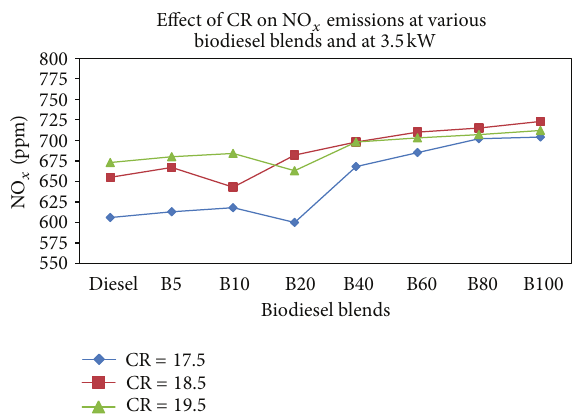
Figure 14: Variation in smoke opacity for various biodiesel blends 180 bar and CR at 𝑃 inj